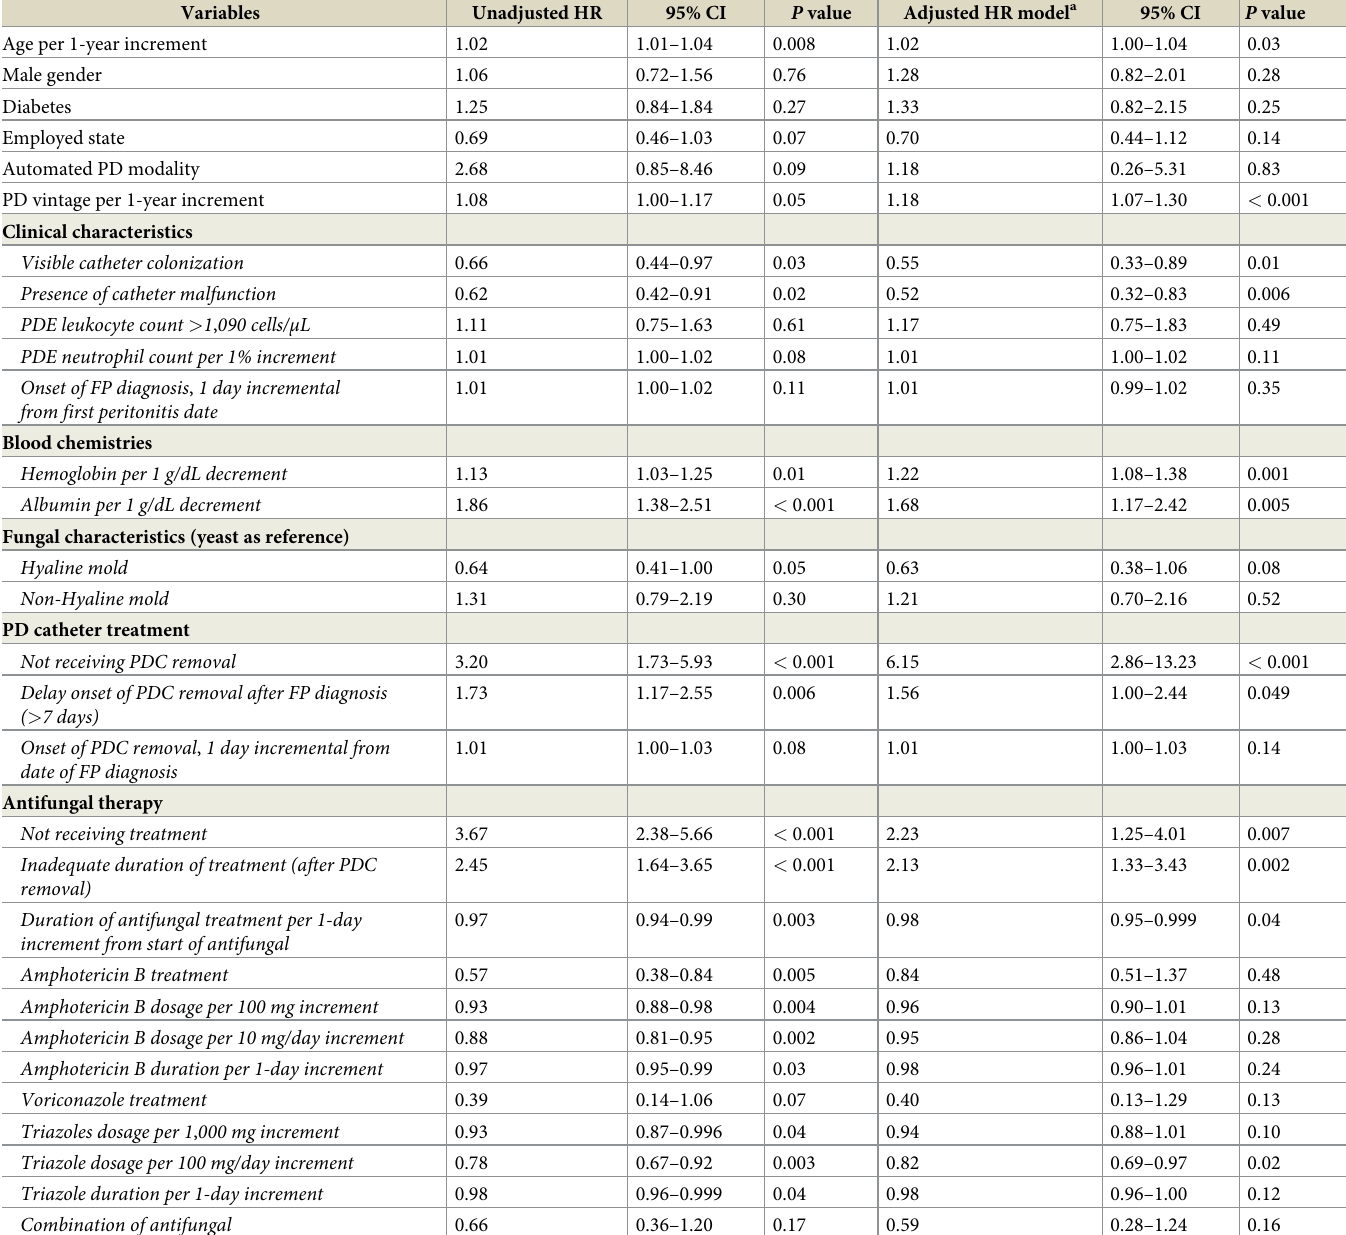
Table 3. Factors associated with mortality in patients with fungal peritonitis using univariable and multivariate analyses. Variables Unadjusted